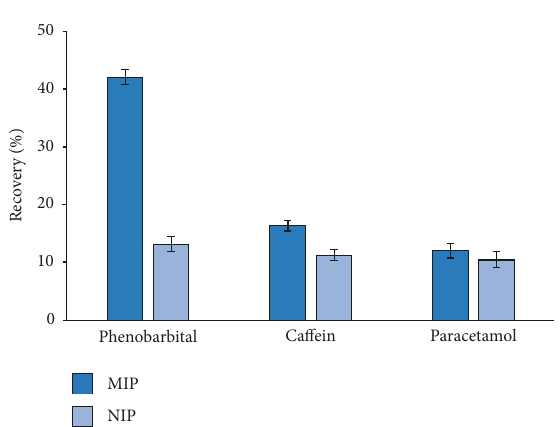
Figure 3: Comparison of the extraction efficiency of the pheno- barbital SPME-MIP and NIP fiber in the presence of caffein and paracetamol, extraction conditions: pH 4.5; desorption solvent: